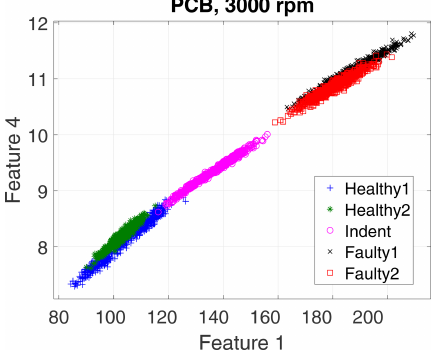
Figure 10. Scatterplot of top two features for the 3000rpm PCB dataset.